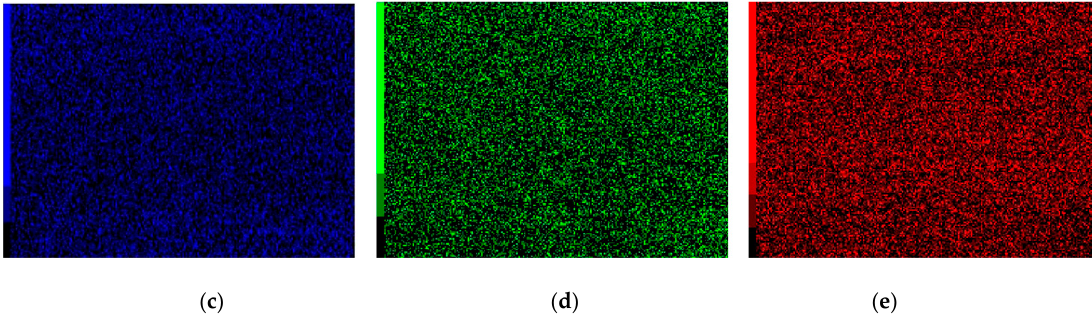
Figure 18. Plane scan analysis of worn track on 24% Cr–76% Ni coating. ( a ) Plane scanned position; ( b ) Plane scan analysis of worn track on 24% Cr–76% Ni coating; ( c ) Distribution of Cr content; ( d ) Distribution of Ni content; ( e ) Distribution of O content.